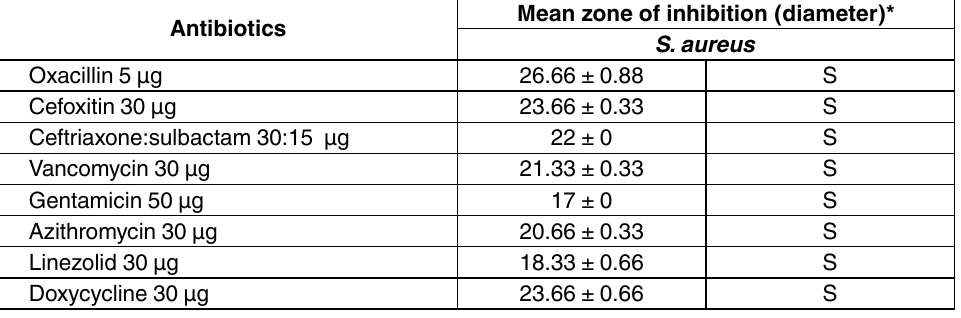
table 2. In vitro antibacterial activity of antibiotic discs against S. aureus using Kirby- Bauer agar disc diffusion method, mm antibiotics